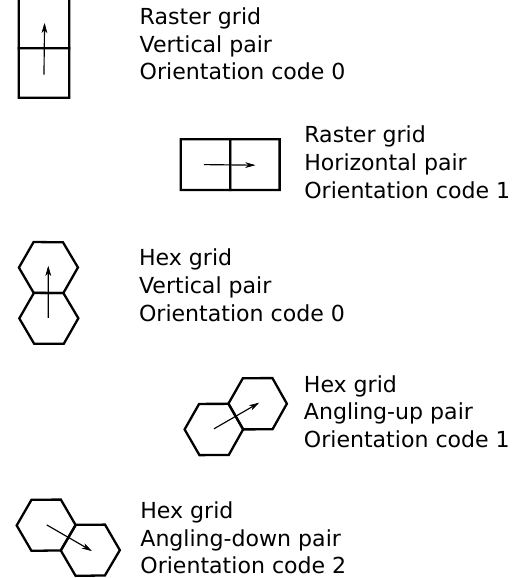
Figure 5. Illustration of cell-pair orientations and corresponding orientation codes. Arrows represent links, each of which connects a tail node to a head node